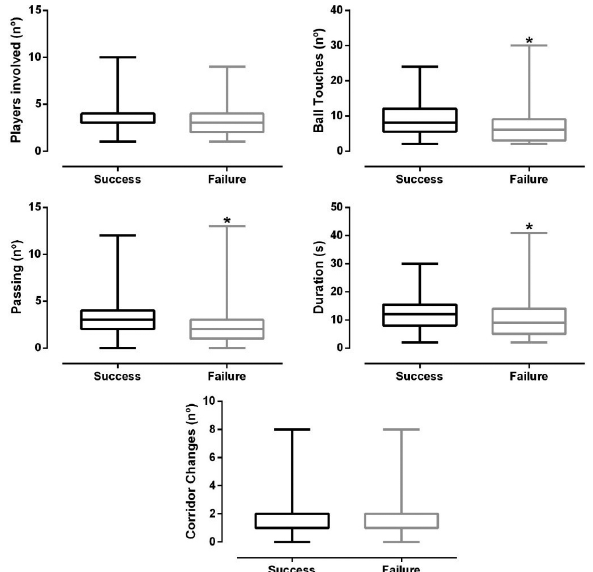
Figure 2. Comparison of tactical-technical indicators according to sequence outcome.